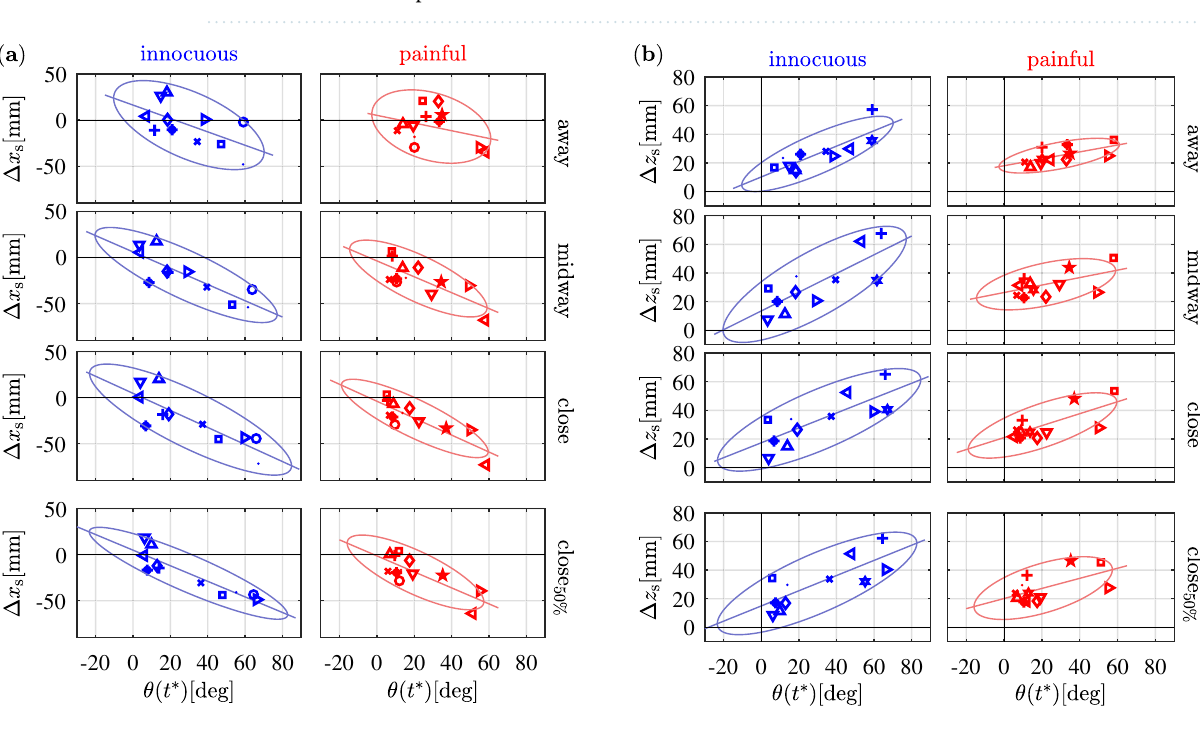
Figure 5. The figure shows mean values of shoulder displacement in the x -direction (cid:31) x s ( a ) and in the z -direction (cid:31) z s ( b ) at the time t ∗ over the elbow upward displacement θ( t ∗ ) . Each symbol represents the mean of such dyad for one individual subject. Ovals denote confidence ellipses with confidence interval 90%. Introducing a painful obstacle (red) reduces the area of the confidence ellipses. Solid lines denote the fitted linear models. In both cases, slopes do not change over